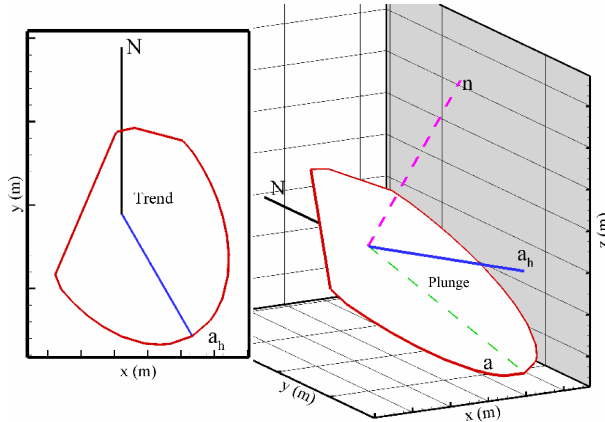
Figure 1. Definitions of fracture orientation for a fracture in a 3-D DFNe. In this study, the positive trend and plunge angles were clockwise from the north and downward from the horizontal plane,